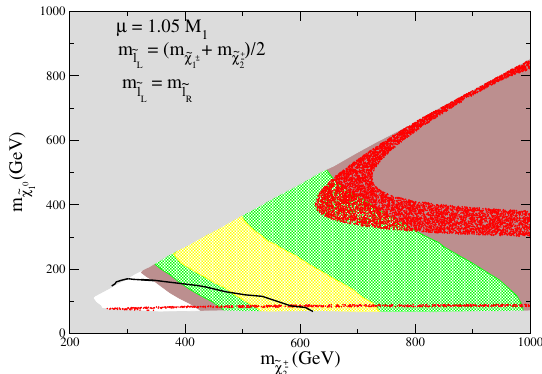
Figure 1 . The black line represents the exclusion contour in m model obtained by our simulation using ATLAS data [42]. The brown, green and yellow regions in the parameter space are consistent with a (cid:22) data at 3 (cid:27) , 2 (cid:27) and 1 (cid:27) level respectively. The red points satisfy WMAP/PLANCK data of DM relic